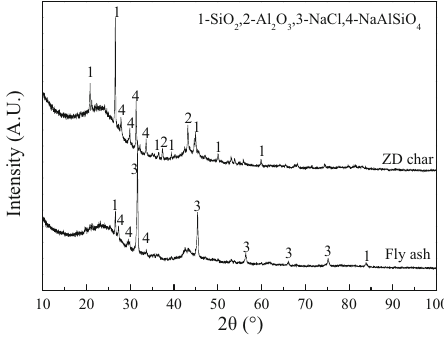
Fig. 6 XRD patterns of ZD char and fly ash